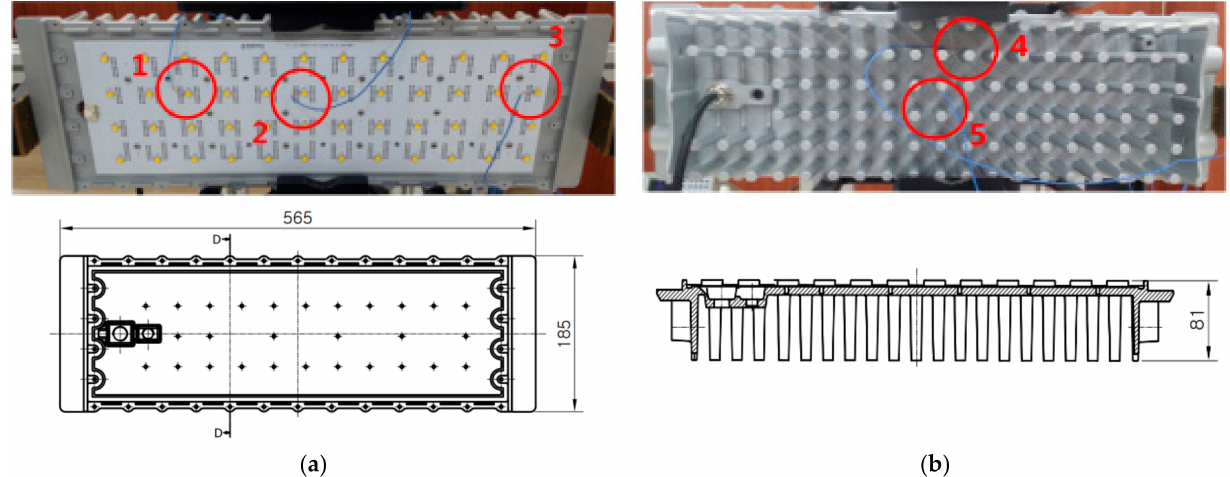
Figure 5. Positions of three thermocouples to monitor the temperature on the top side of the heatsink ( a ) and two thermocouples on the bottom side of the heatsink ( b